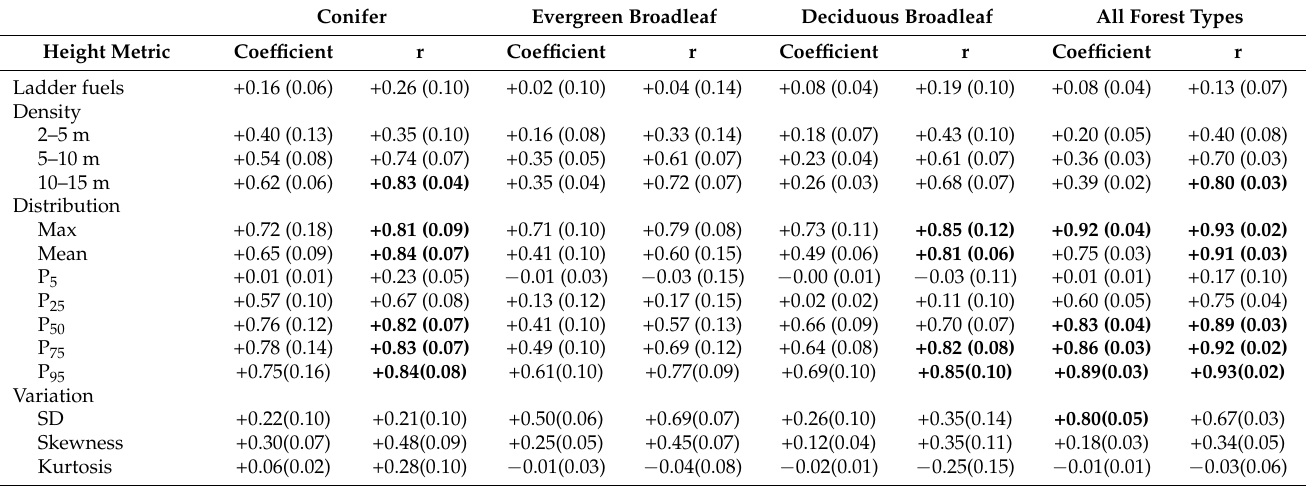
Table 3. Regression slope coefficients and Pearson’s r correlation coefficient for point cloud grid metrics comparison between ALS data and UAS-SfM height normalized using an ALS DTM. Metrics P 5 , P 25 , etc. represent height percentiles. Values given are mean (standard error) of 10,000 bootstrap replicas of 100 unburned plots per forest type. Coefficient and r values greater than 0.8 are shown in